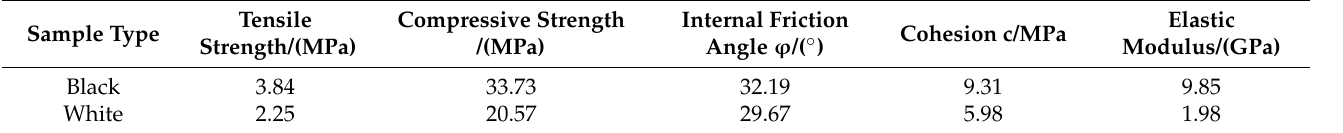
Figure 3. The failure samples in: ( a ) TCS test; ( b ) Brazilian splitting test. Table 2. Mechanical parameters of SMS sample.